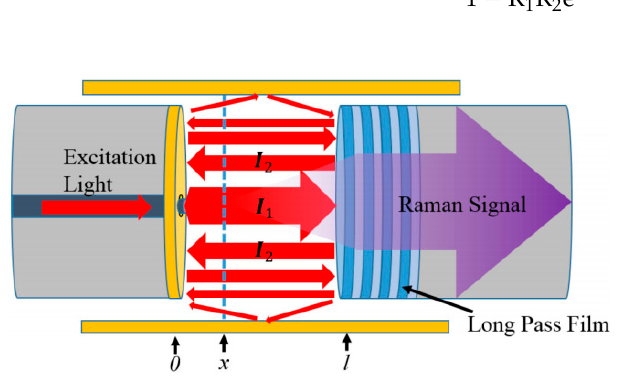
Figure 7. Schematic diagram of excitation light reflecting back and forth in the cavity, while the total